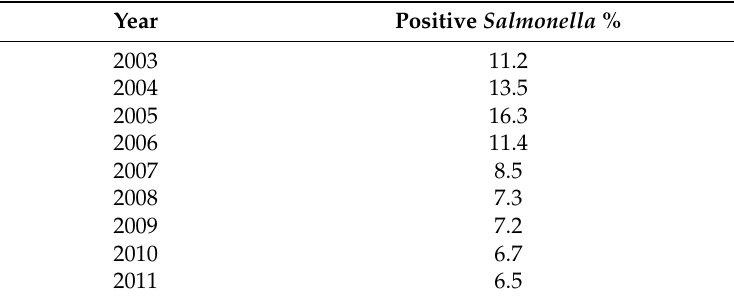
Table 1. Percent positive Salmonella in broiler chicken during